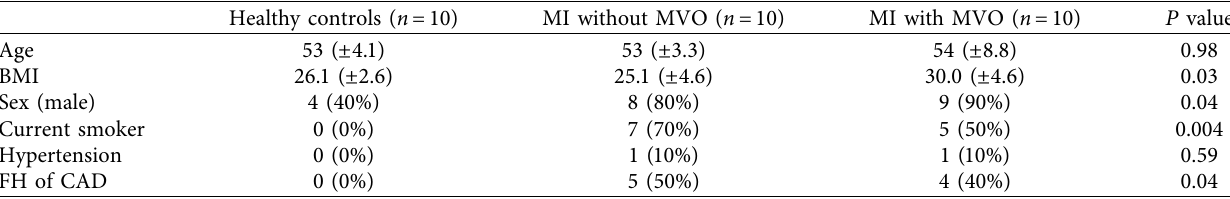
Table 1: Baseline characteristics stratifed by clinical group.